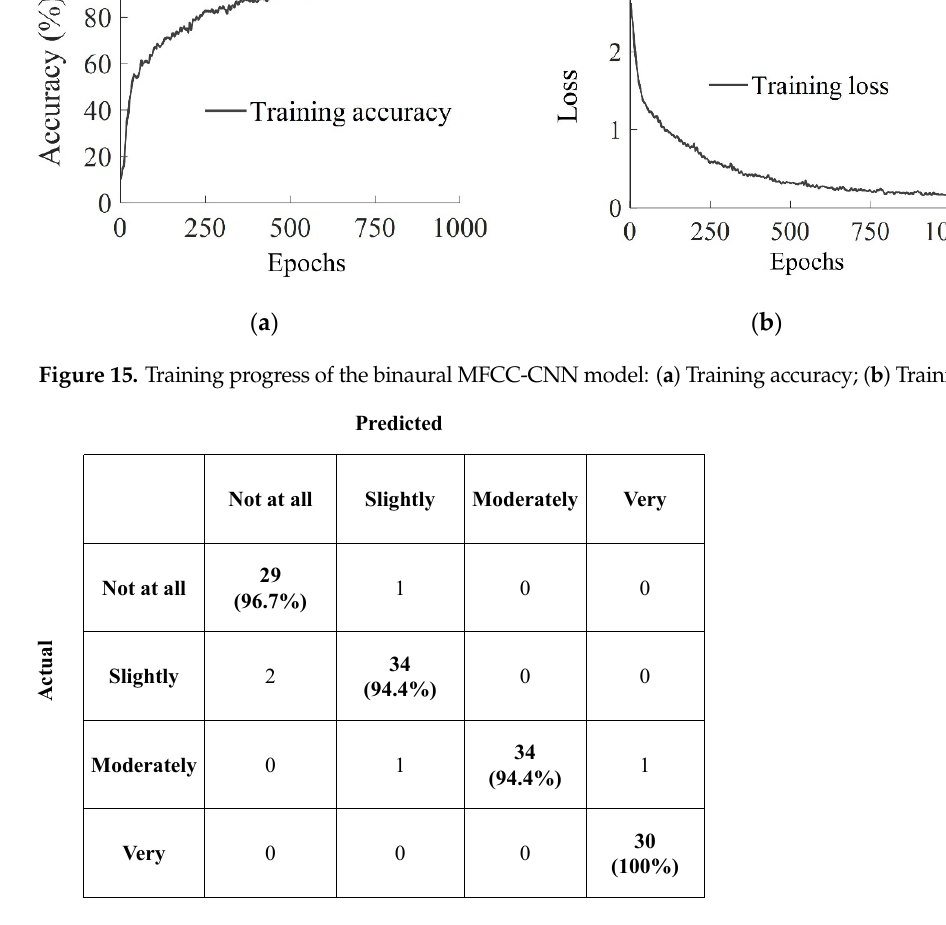
Figure 16. Confusion matrix of testing data set of the binaural MFCC-CNN model.